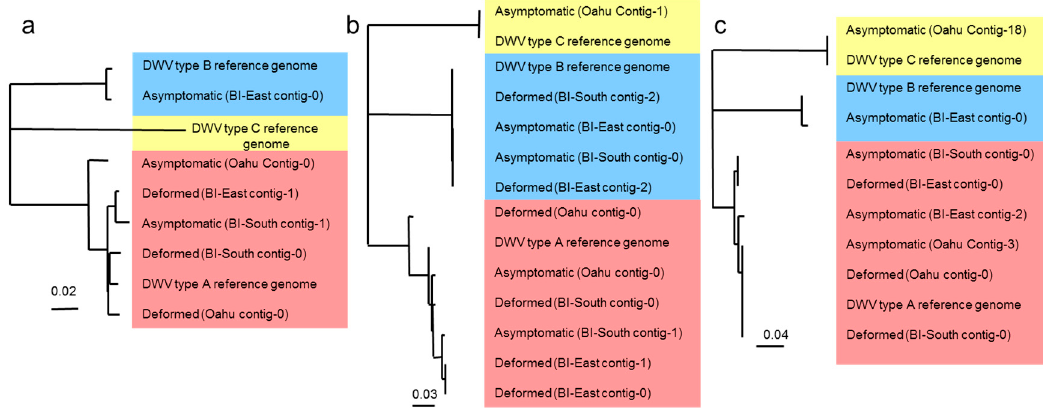
Figure 3. Phylogeny (neighbor joining) of type A, B and C Vicuna contigs covering the ( a ) 4360 bp region spanning the majority of the non-structural block; ( b ) RdRp region [11] and ( c ) Capsid region. DWV type A, B and C sequences are highlighted in red, blue and yellow respectively. The low diversity of type B sequences can be attributed to a low viral load. At no gene location do the deformed and asymptomatic form groups. BI= Big Island.